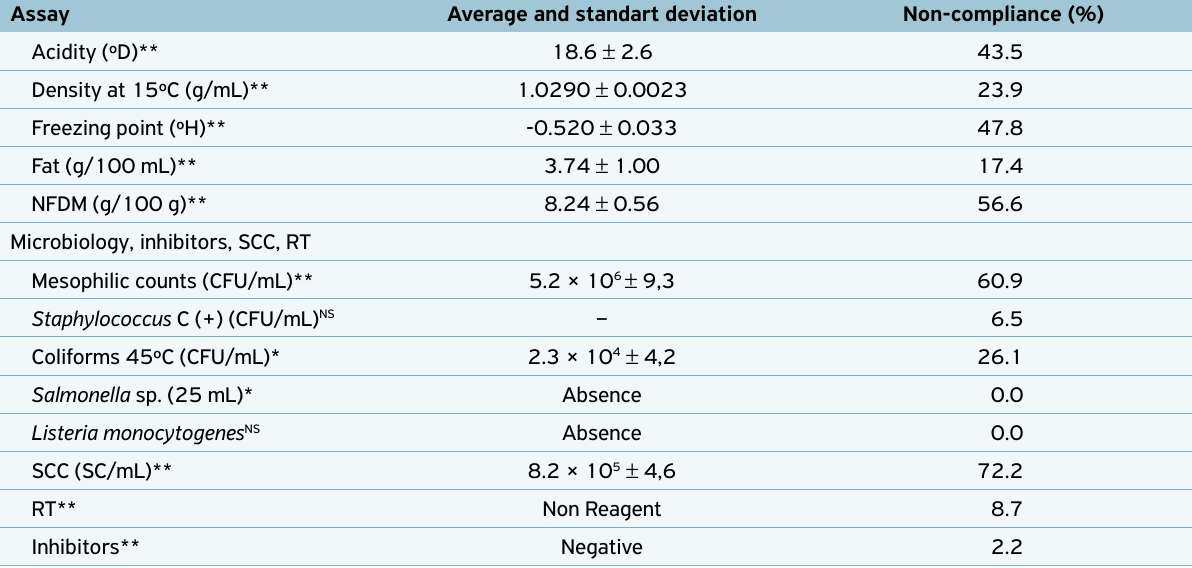
Table 3. Results of the laboratory assays carried out in uninspected raw milk and non-compliance with official regulations: n = 46; for SCC assay, n =